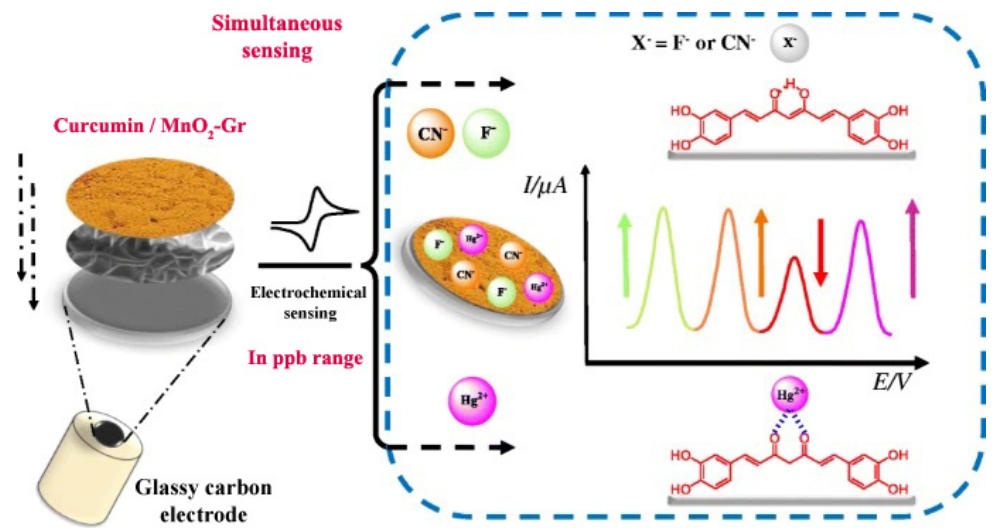
Figure 14. Schematic presentation of the polycurcumin-based sensor and its response to Hg(II), fluoride, and cyanide. Reprinted from [85] with permission from Springer Nature.